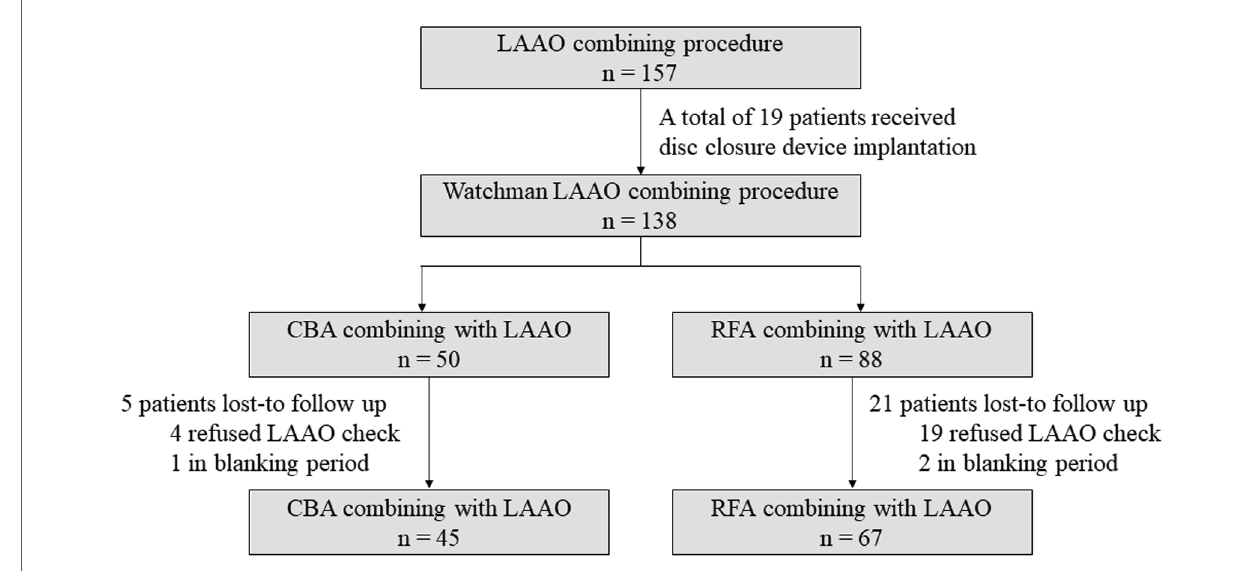
FIGURE 1 Study fl owchart. LAAO, left atrial appendage occlusion; CBA, cryoballoon ablation; RFA, radiofrequency